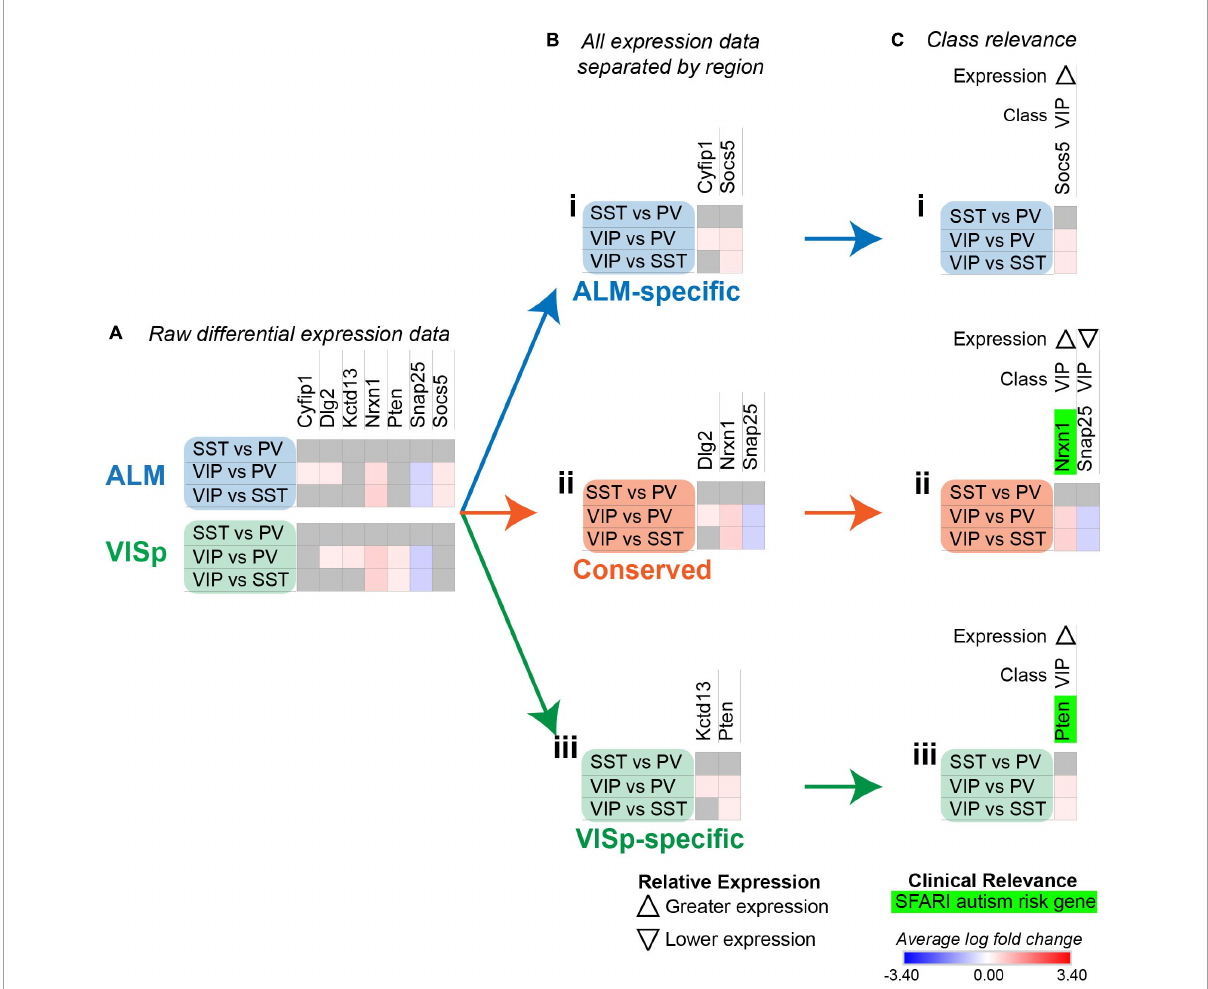
FIGURE5 Strategy to determine circuit-related genes relevant to specific neuronal classes. Each row (e.g., SST vs. PV) presents the results of differential expression tests between neuronal classes. Differential expression results are always relative to the first neuronal class in a comparison (e.g., SST in ‘SST vs PV’). Gray indicates no significance in differential expression. Shades of red and blue indicate the log fold change of average expression for tests that were statistically significant. (A) Examples of differential expression rests results for seven circuit-related genes in interneuron classes in ALM and VISp. (B) Separation of genes from (A) into ALM-specific (Bi), Conserved (Bii) , and VISp-specific (Biii) subsets. (C) Class-relevant genes from (B) identified by their consistent differential expression results among all class tests. For each gene, we provide a class-relevant label and an arrow indicating whether it is expressed higher or lower relative to other classes. Class-relevant genes listed on the SFARI Human Gene Module implicated in autism were highlighted